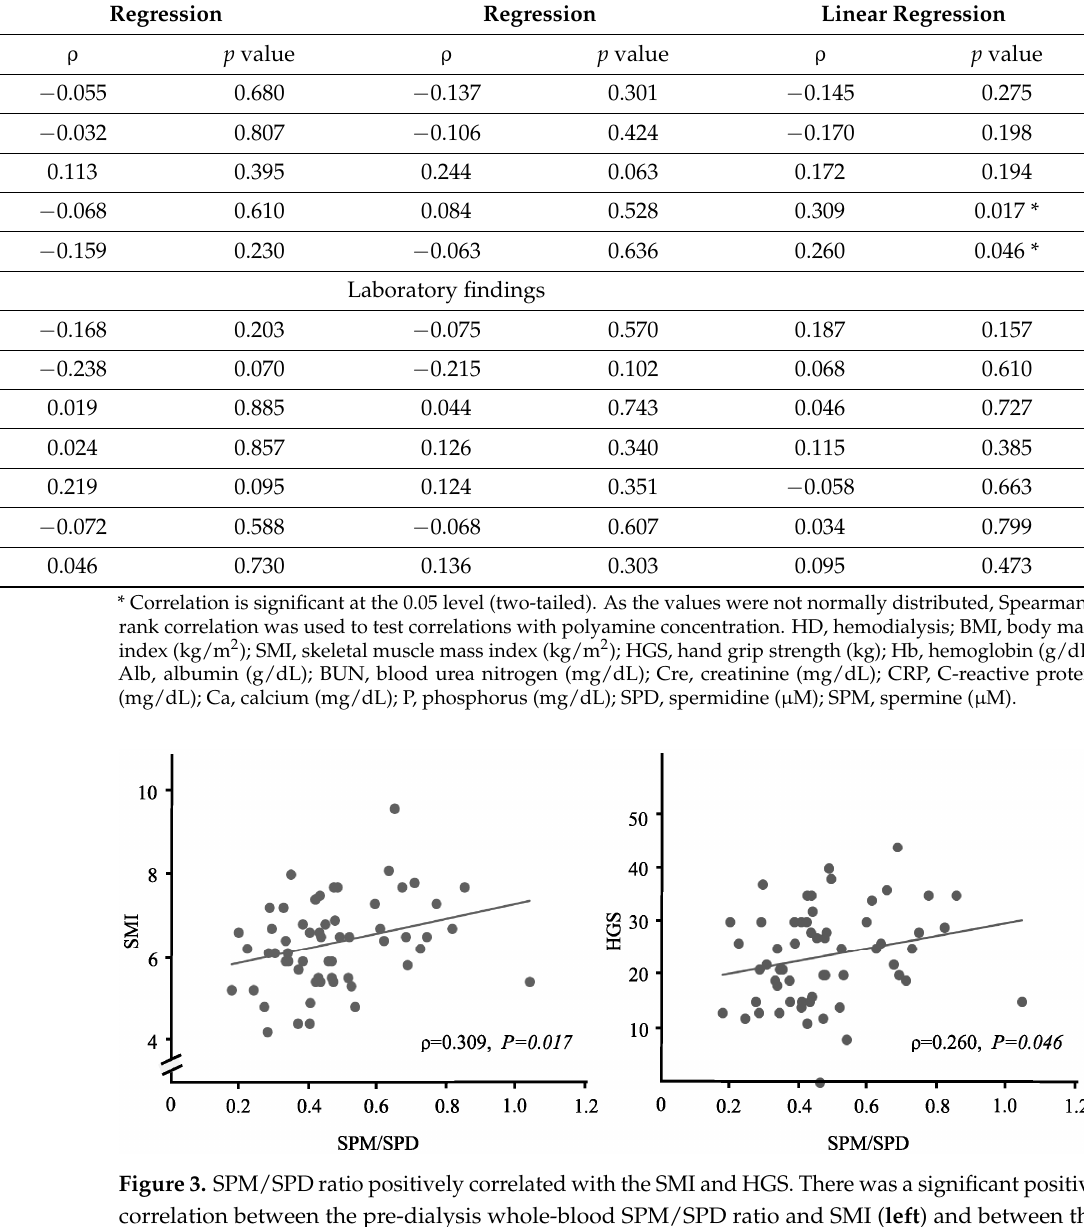
Table 3. Correlations between clinical parameters and polyamine.